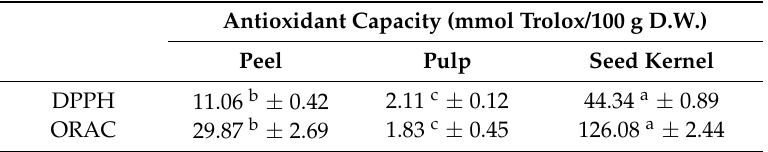
Table 5. Antioxidant capacity in mango organs (peels, pulps and seed